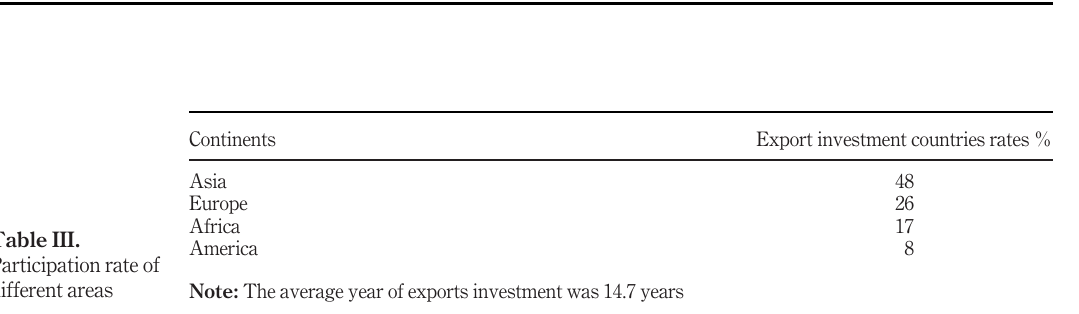
Table II. The response rate of